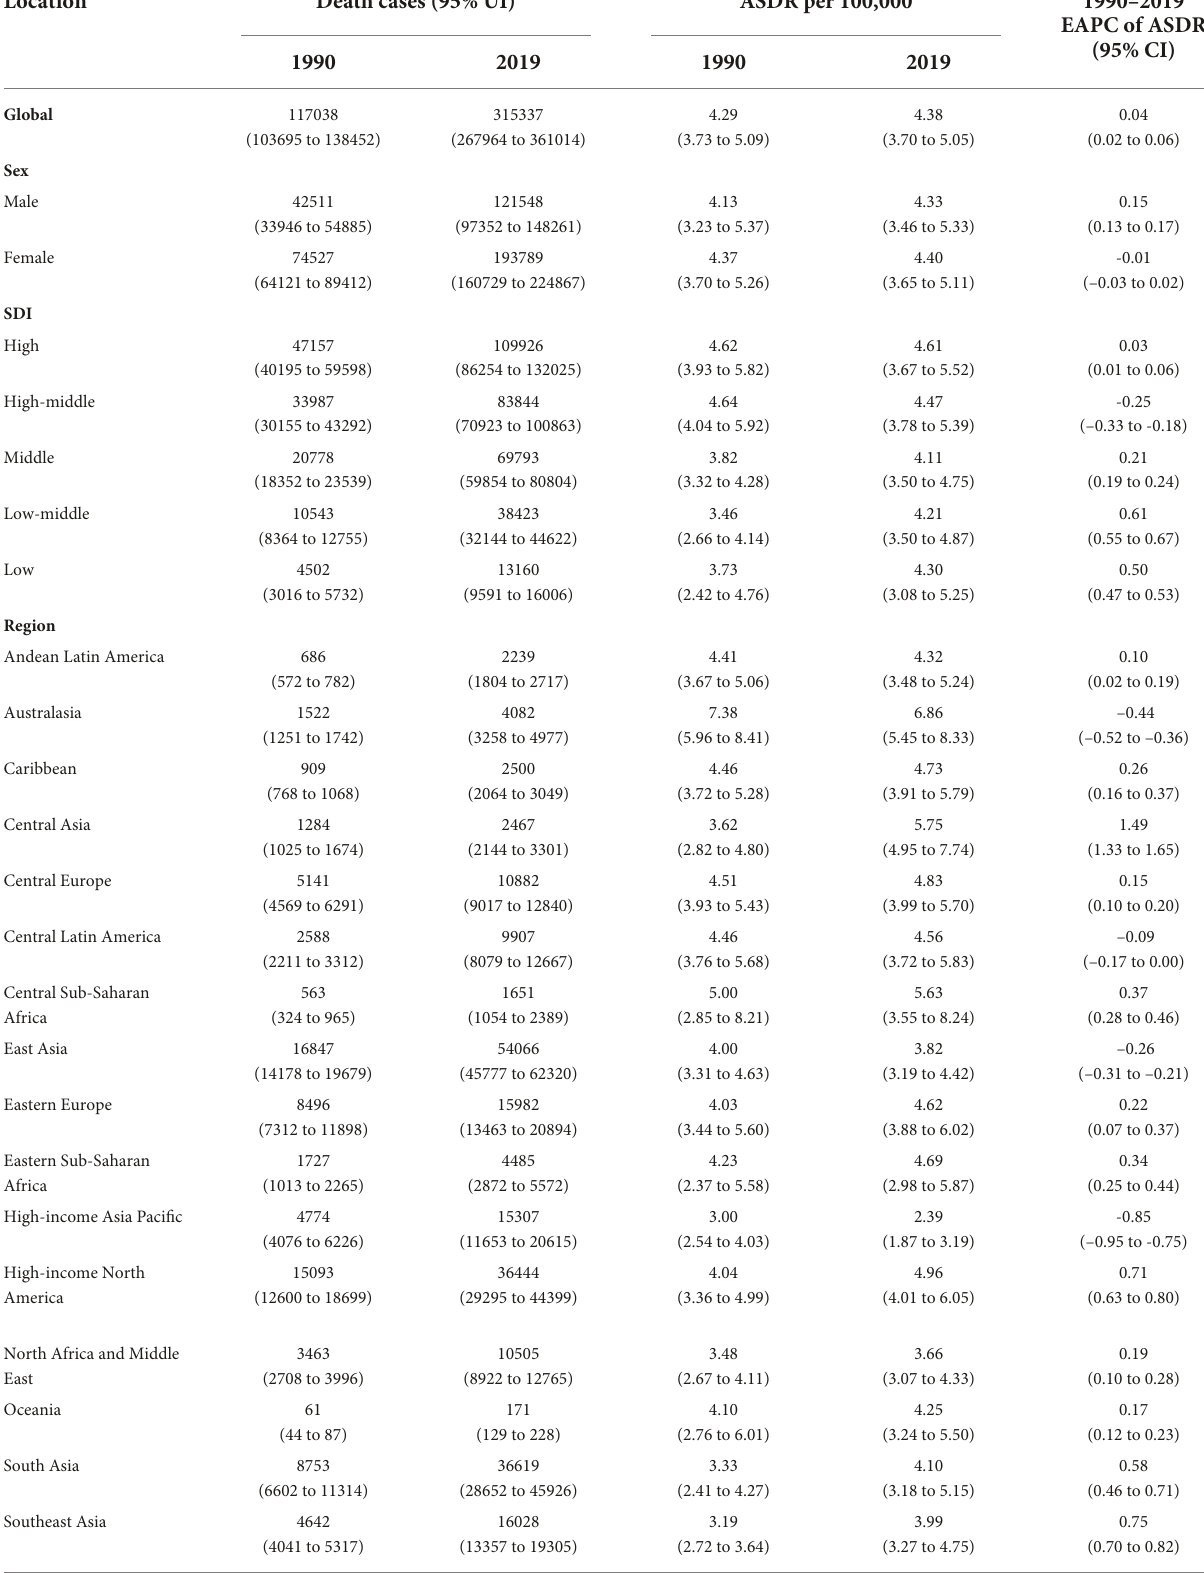
TABLE 2 The death of atrial fibrillation in 1990 and 2019, and its temporal trends from 1990 to